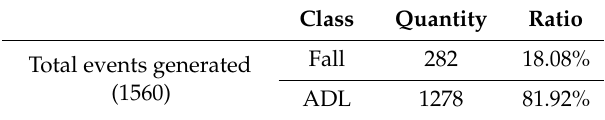
Table 8. Event-level group creation results and configuration using the test dataset in Table 7.